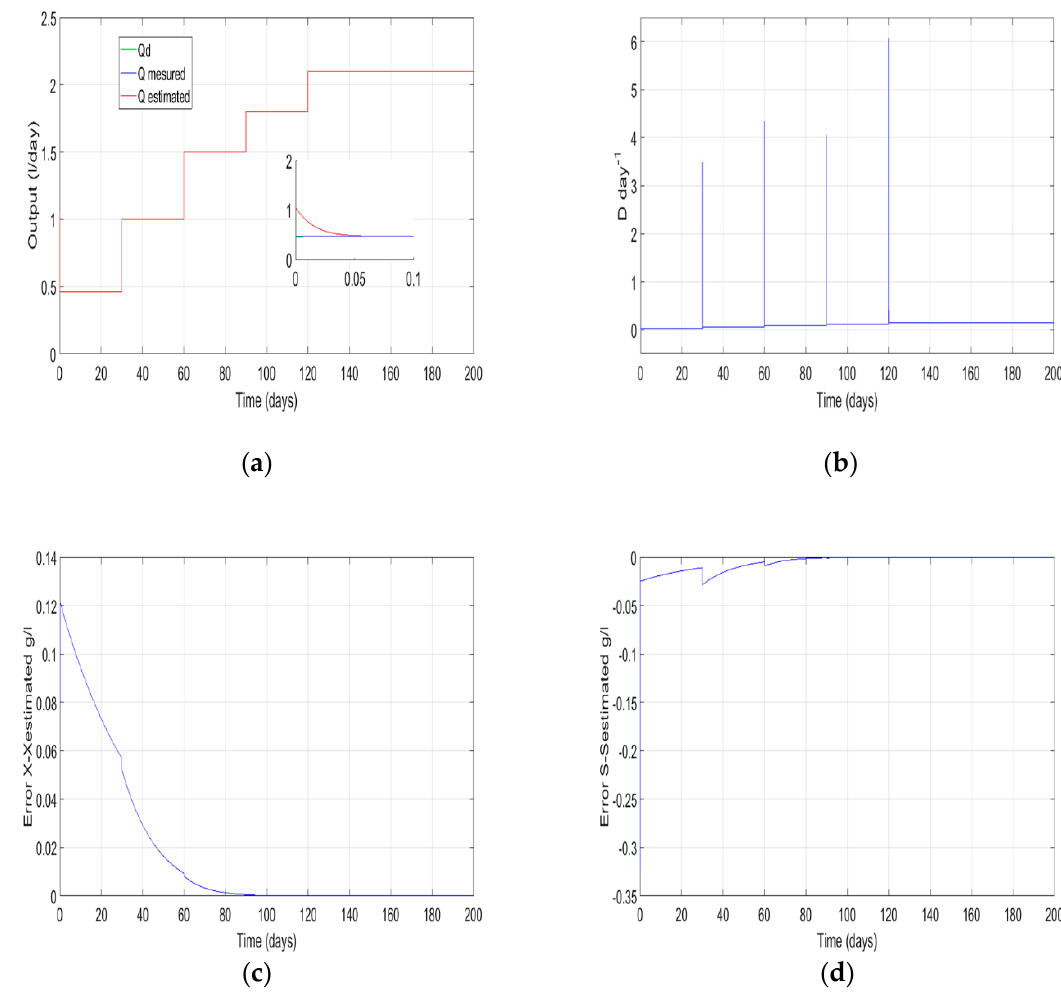
Figure 5. Linear feedback observer based synergetic controller. ( a ) Time evolution biogas flow rate; ( b ) control signal evolution; ( c ) error of the bacterial concentration evolution; ( d ) error of the substrate concentration evolution. Starting with 0 0 ( ) Q ≠